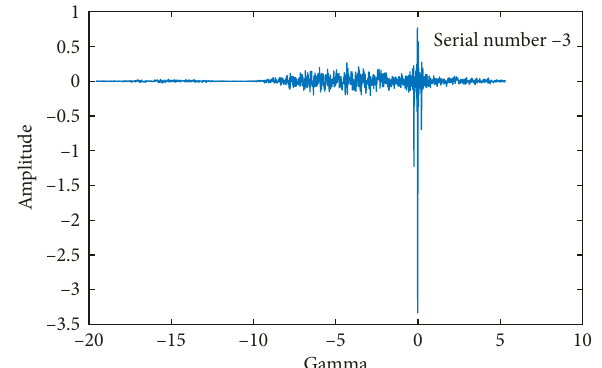
Figure 11: The real part of the negative signal in the frequency domain.